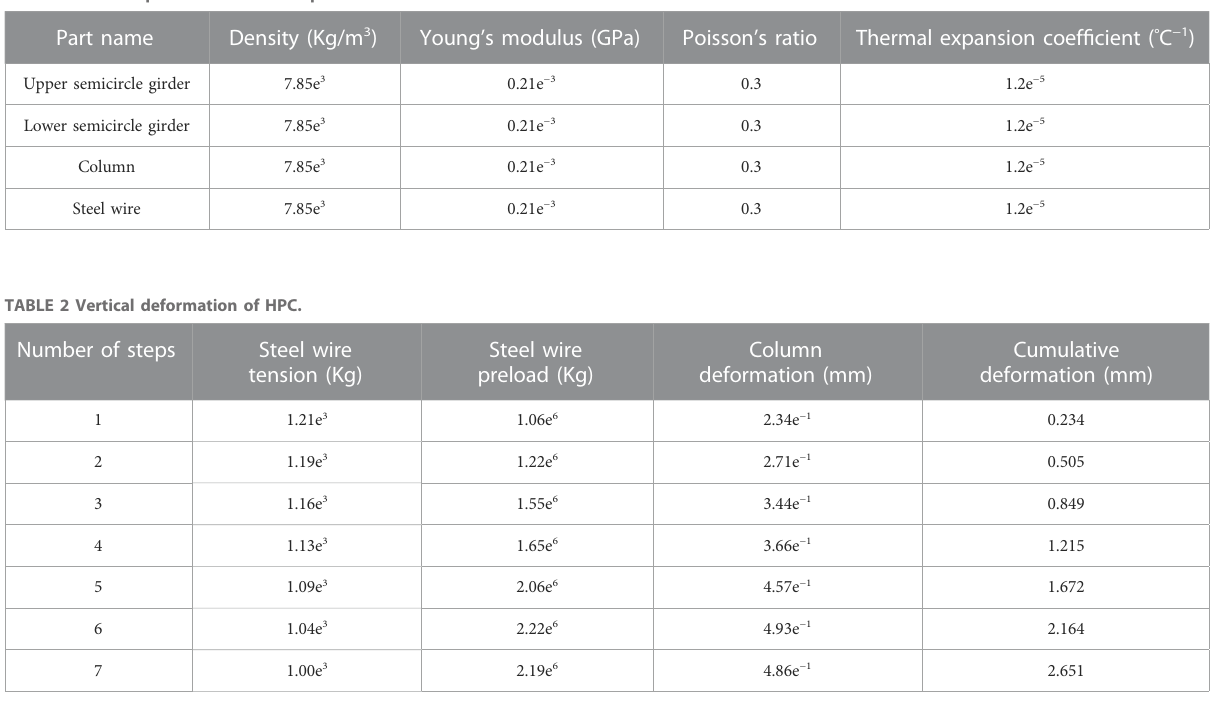
TABLE 1 Material parameters for each part of the frame.